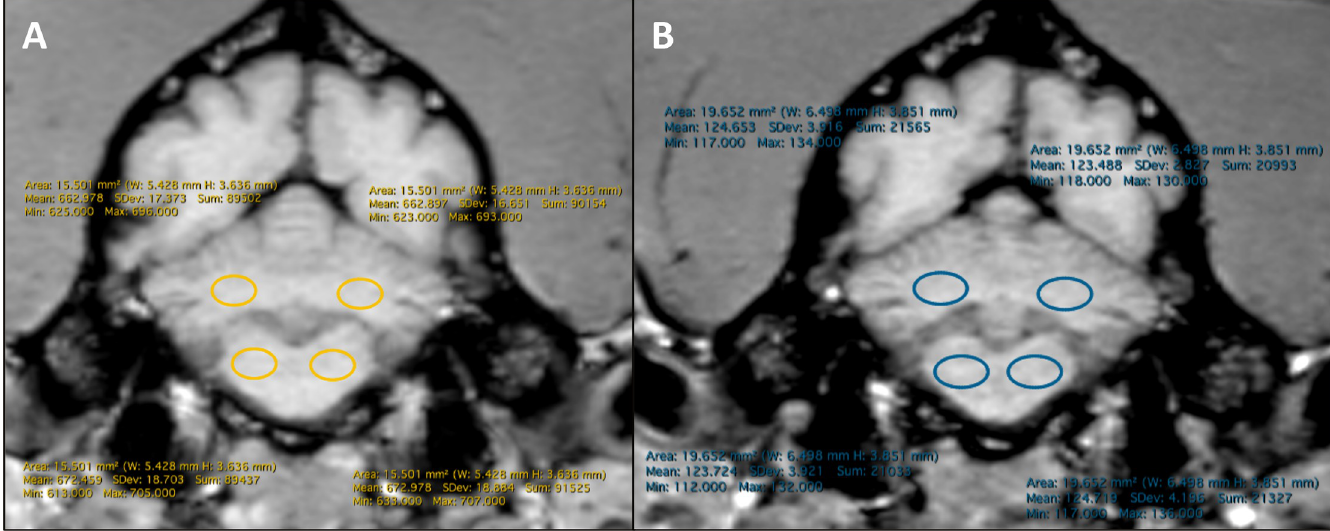
Fig 1. T1 weighted unenhanced images a dogs brain in transversal orientation at the level of DCN; Colored circles indicate ROI at the Pons (proximal circles) and DCN (distal circles) in the left and right hemisphere A: first examination precontrast, B: second examination precontrast 105 days after first examination; related SI measurements of the ROIs showing measured area in mm 2 , Mean, Min, Max and SD of SI in the ROI.